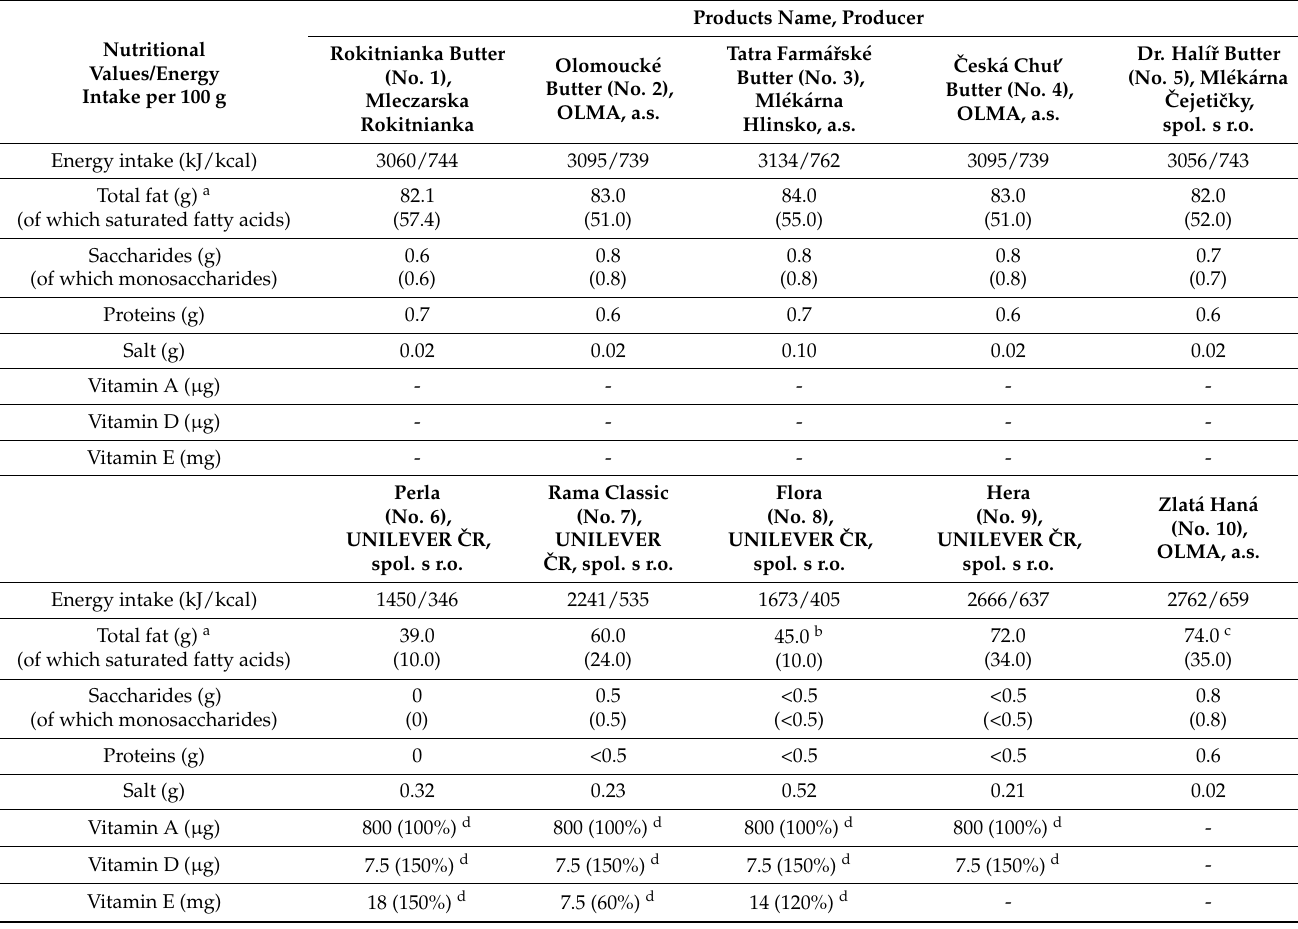
Table 1. Nutritional characteristics of butters, spreadable fats, and shortenings per 100 g of the